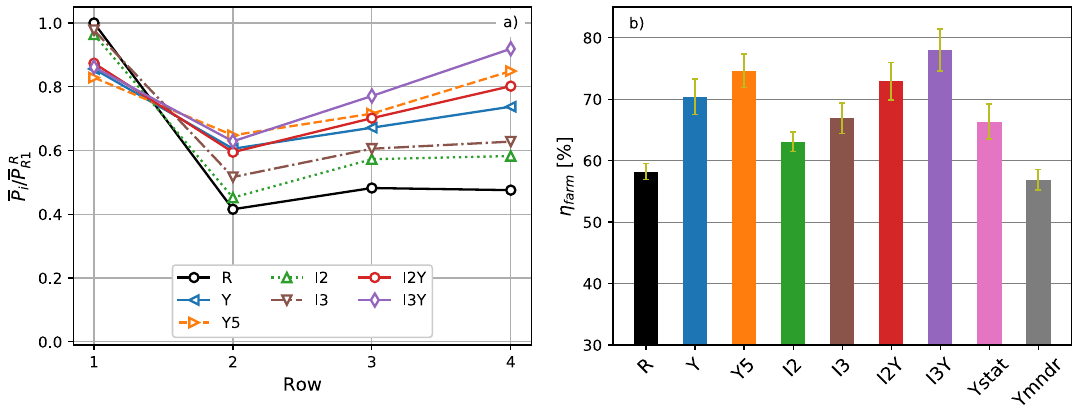
Figure 12. Wind-farm power extraction for reference case R, optimal control cases (Y, Y5, I2, I3, I2Y, and I3Y), and derived control cases (Ystat and Ymndr). ( a ) Column-averaged power per row,